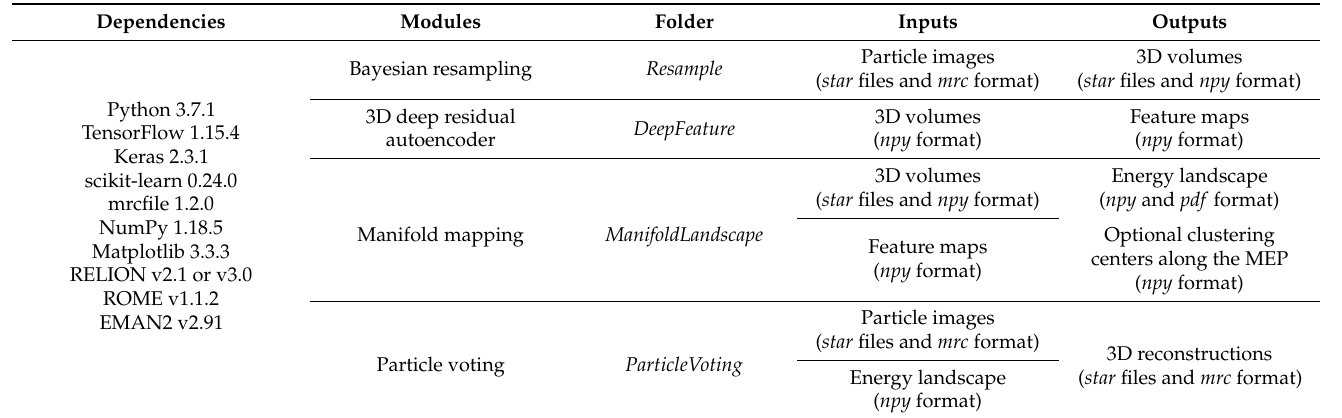
Table 3. Dependencies and I/O of four modules in